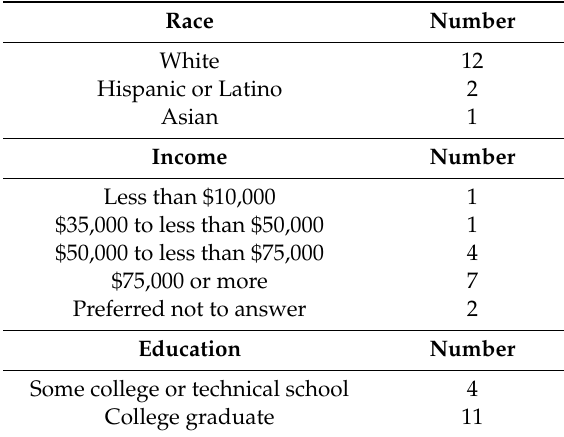
Table 1. Demographics breakdown of participants in this study.